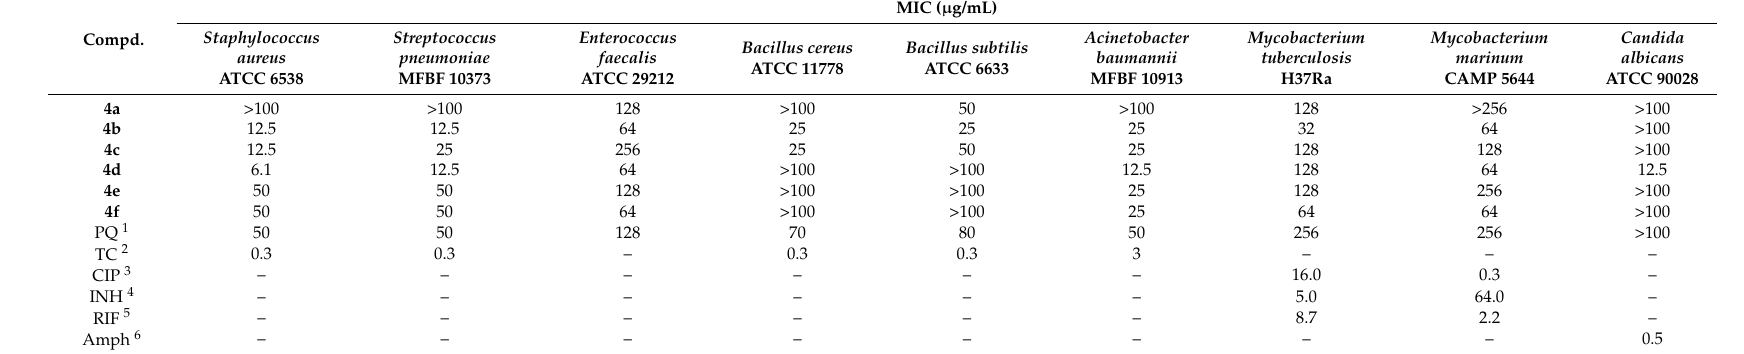
Table 1. Antimicrobial susceptibility assay in vitro (minimum inhibitory concentration (MIC) determination) for compounds 4a – f .